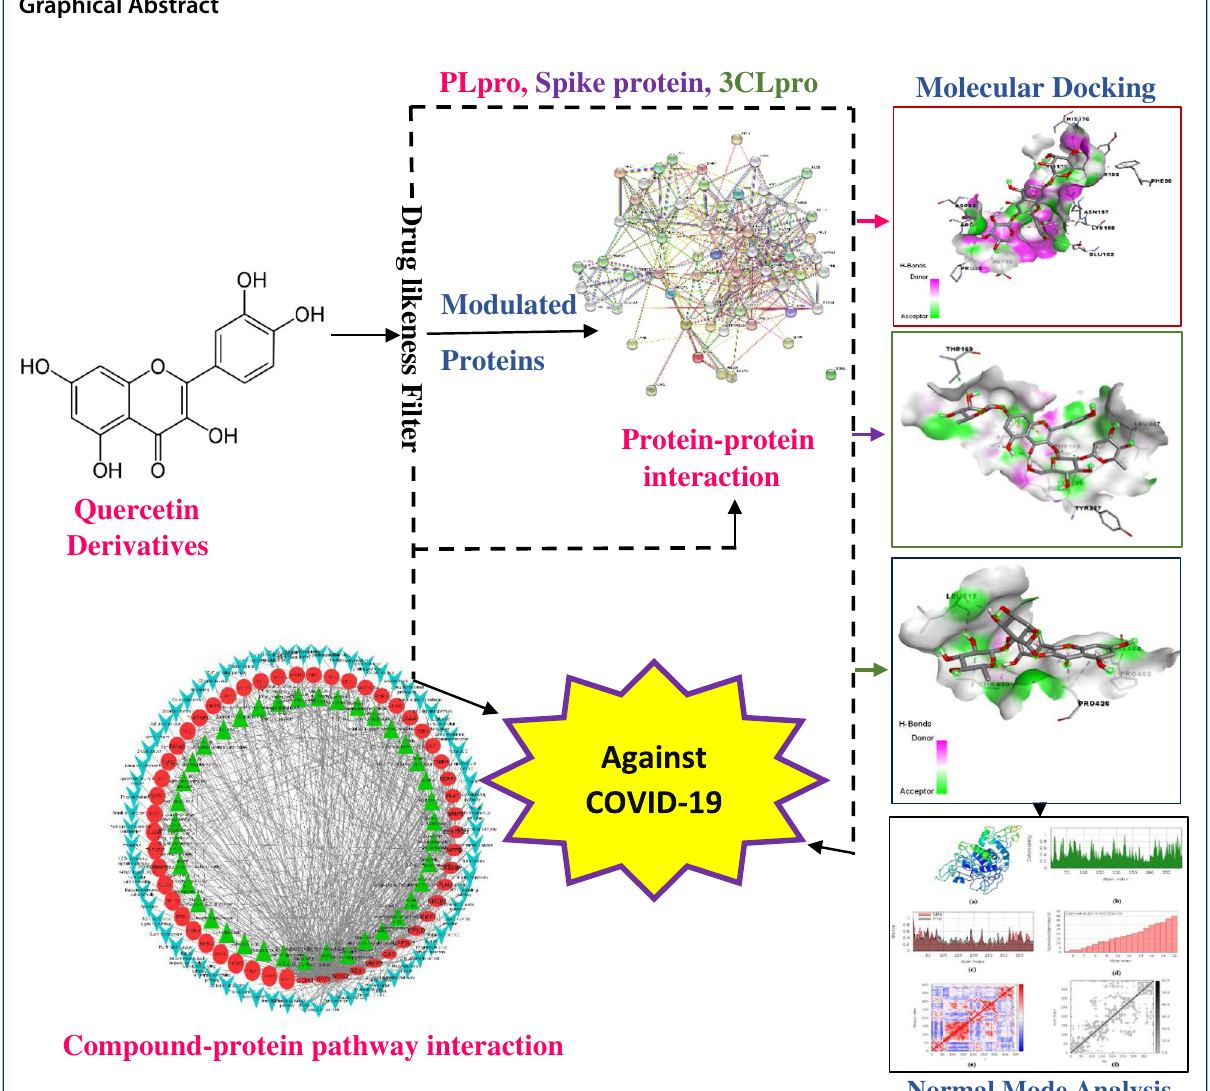
Keywords: 3CLpro, PLpro, Spike protein, Quercetin derivatives,